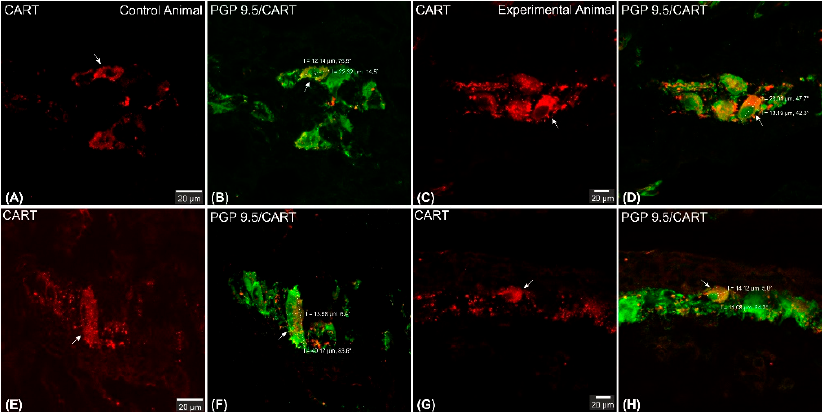
Figure 4. Set of exemplary photomicrographs double immunostained for CART (red channel) and PGP 9.5 (green channel) showing morphology (including dimensions) of double immunoflu- orescent myenteric perikarya (arrows). ( A – D )—pictures indicating typical myenteric perikaryon (arrow) observed in the control ( A , B ) and experimental ( C , D ) animals. High intensity of CART- immunofluorescence observed in the experimental animal perikaryon ( C ). ( E , F ) Very large and ( G , H ) small perikarya occasionally observed in both groups of animals. Scale bars included in the pictures. Both channels overlapped in ( B , D , F , H ) pictures. Measurements (long/short axis) made with confocal microscope software and incorporated by graphical